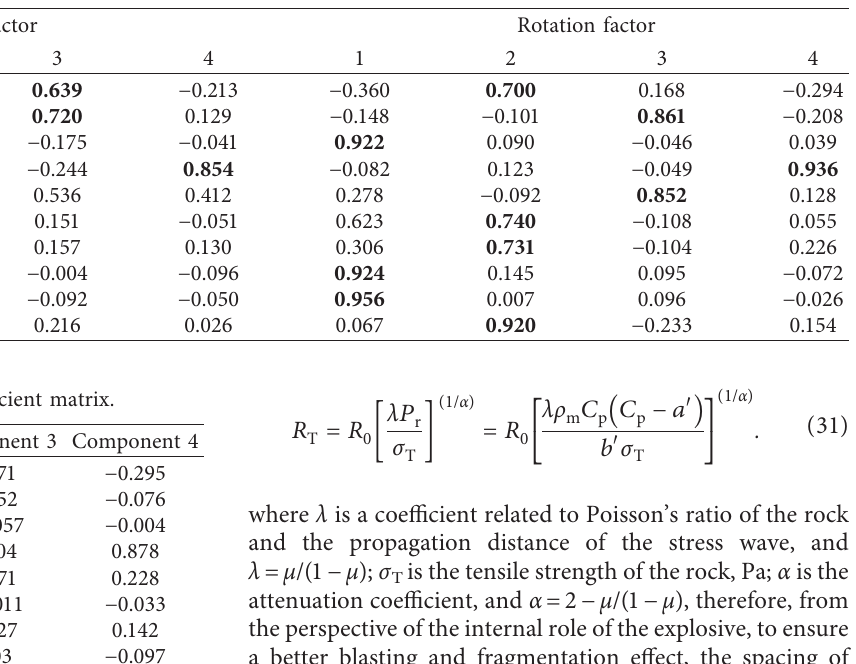
Table 3: Component matrix and rotated component matrix.